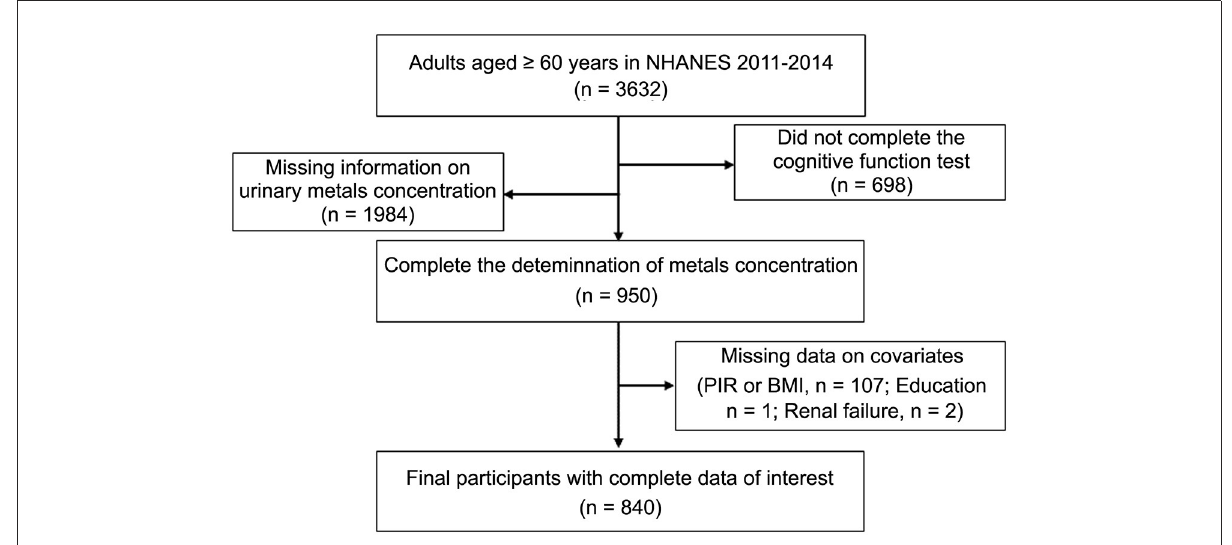
FIGURE1 Flow chart of the selection of eligible